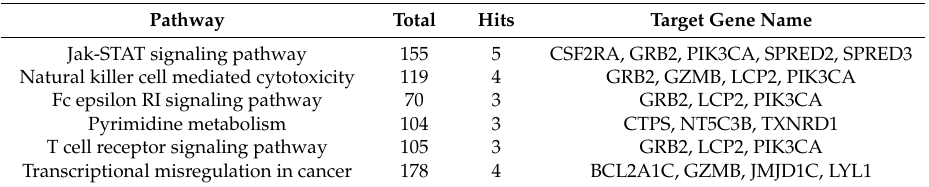
Table 6. Pathway Results.